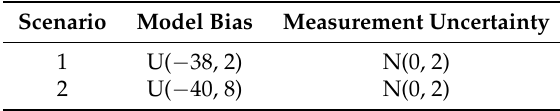
Table 3. Distribution of uncertainty sources affecting structural identification. Uncertainties were estimated relative (%) to design model predictions.